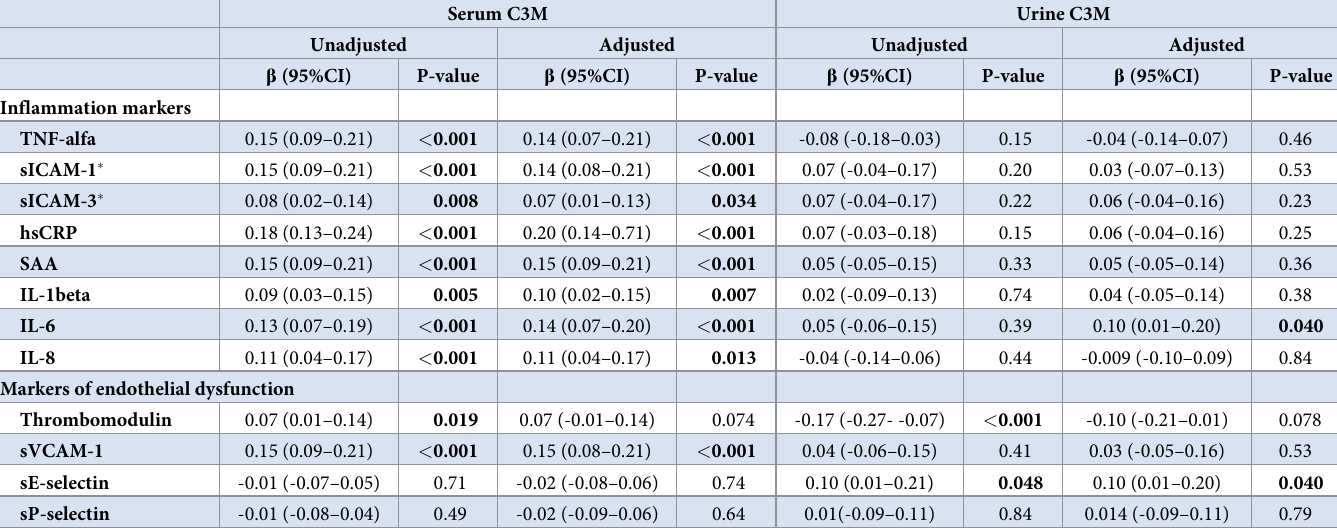
The β -estimates with 95% confidence interval (CI) represent standardized effect (log2 transformed). Adjustment included sex, age, body mass index, LDL cholesterol, smoking, HbA1c, plasma creatinine, systolic blood pressure and urinary albumin excretion rate. � Also markers of endothelial dysfunction. Bold indicate a significant p-value.